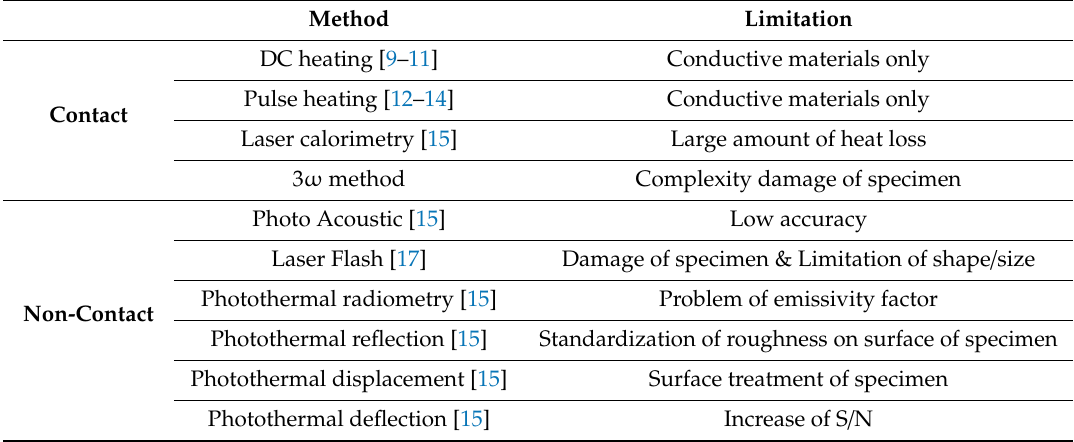
Table 1. Various thermal property measurement methods and limitations.